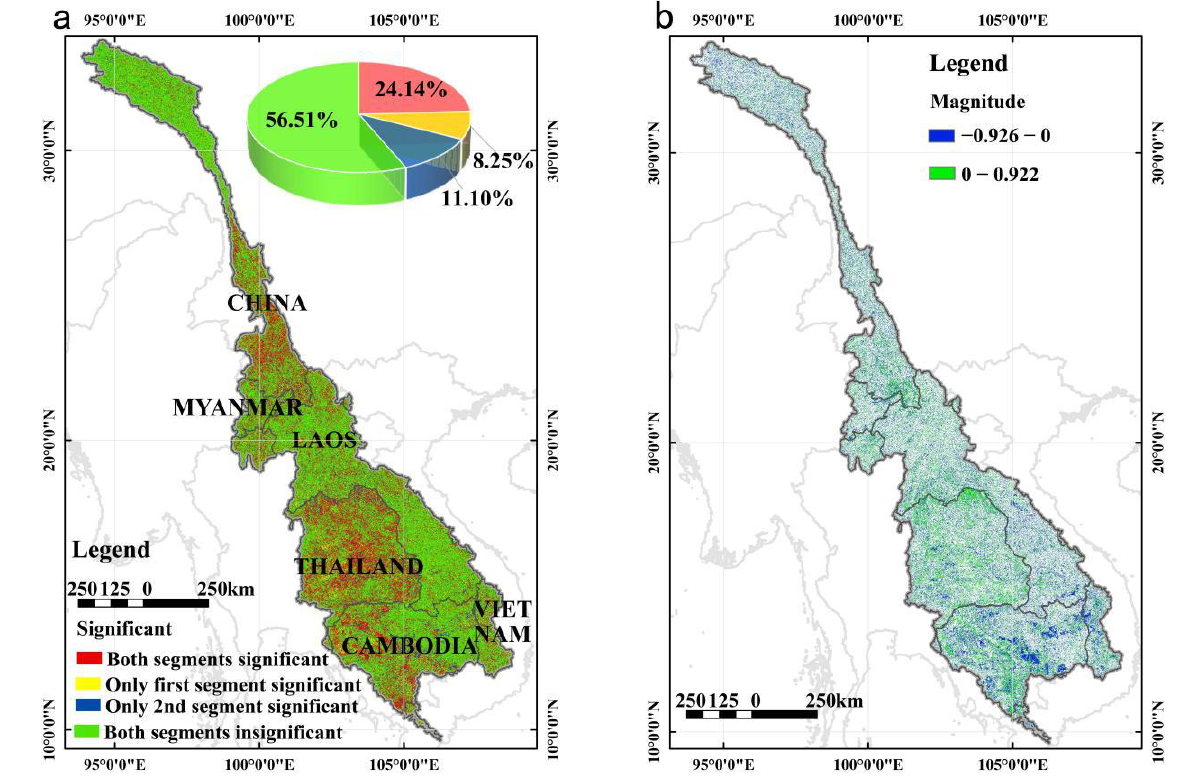
Figure 8. Significance test and change magnitude map of BFAST01 ( a ) Significance ( b ) magnitude.